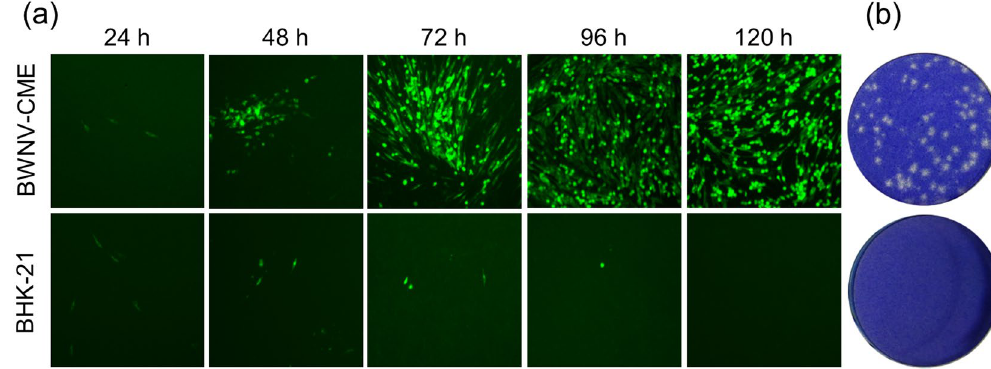
Figure 6. Propagation characteristics of RRPs in BWNV-CME and BHK-21 cells. ( a ) The spread of green fluorescence in BWNV-CME cells infected with RRPs. In RRP-infected BHK-21 cells, the green fluorescence expressing cells did not increase from 24 h post-infection. The BWNV-CME and BHK-21 cells were seeded into 24-well plates and inoculated with RRPs for the indicated time periods. For detection of plaques, the infected cells were overlaid with Eagle’s medium containing 1.5% carboxymethyl cellulose and 1% foetal calf serum. The morphological changes of one plaque were observed with a fluorescent microscope. ( b ) WNV plaque formation in WNV-CME cells. Six days post-infection, the plates were stained with 0.1% crystal violet solution for 15 min at room temperature. The stain was discarded and the cells were rinsed with tap water.